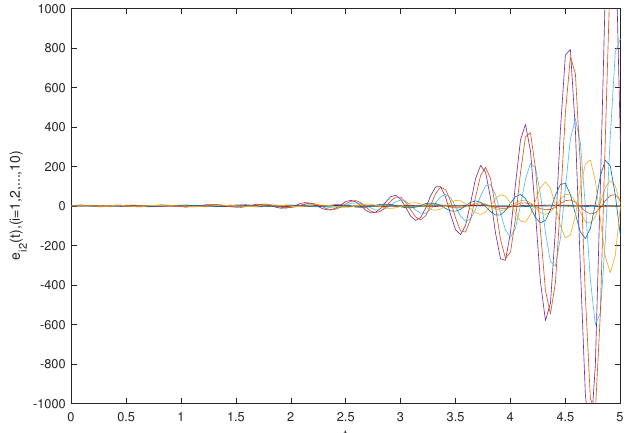
Figure 3. Synchronization errors e i 2 ( i = 1,2, · · · ,10 ) of the fractional-order system (32) and (33) without the controllers.